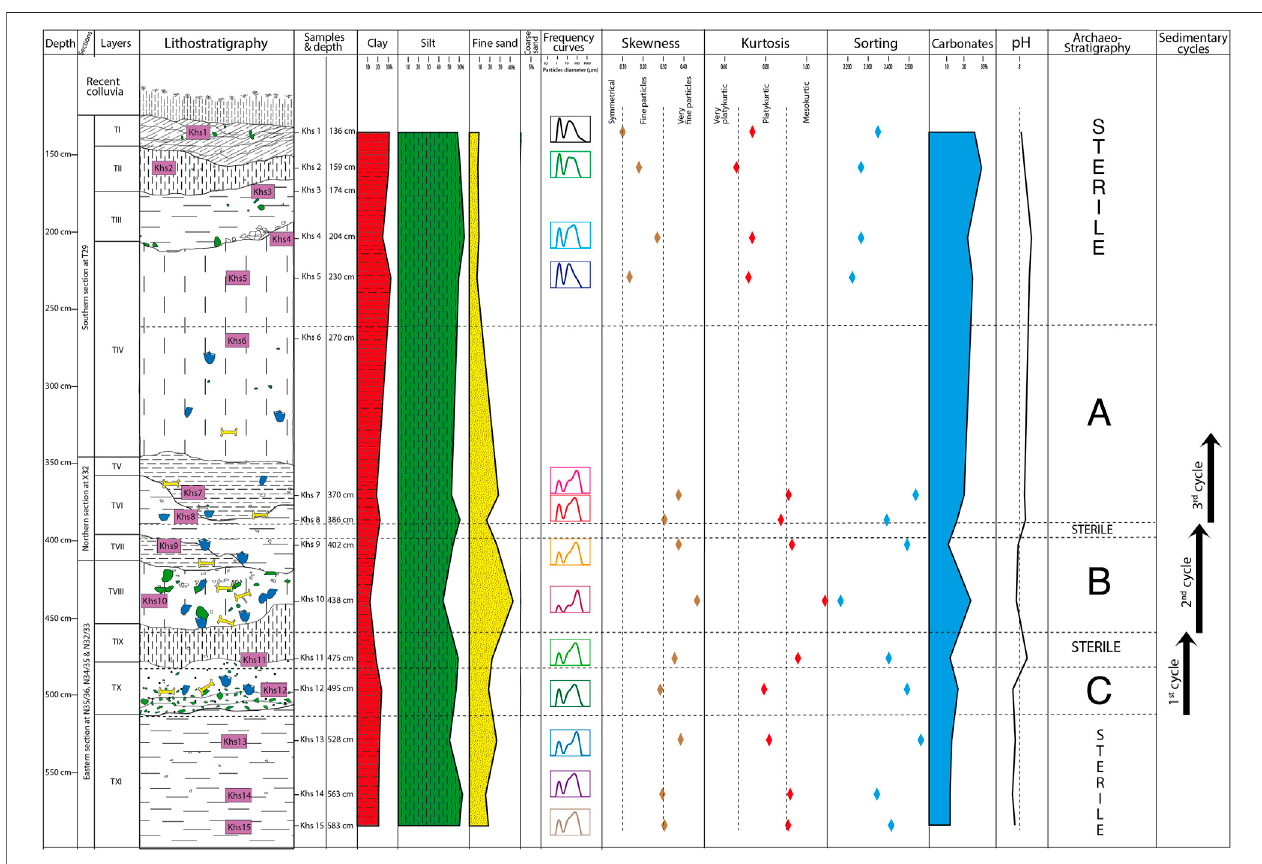
FIGURE4| Sedimentological resultsincludinggrainsizeshowingproportions of fi neparticles,frequencycurves,kurtosis,skewness, sorting,carbonates,pH,and sedimentary cycles.